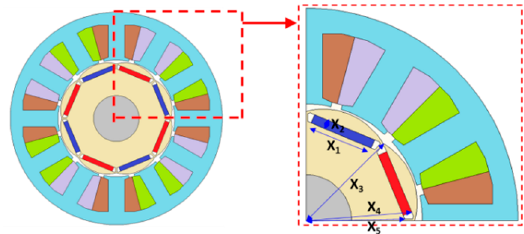
Figure 4. Rotor shape design variables.